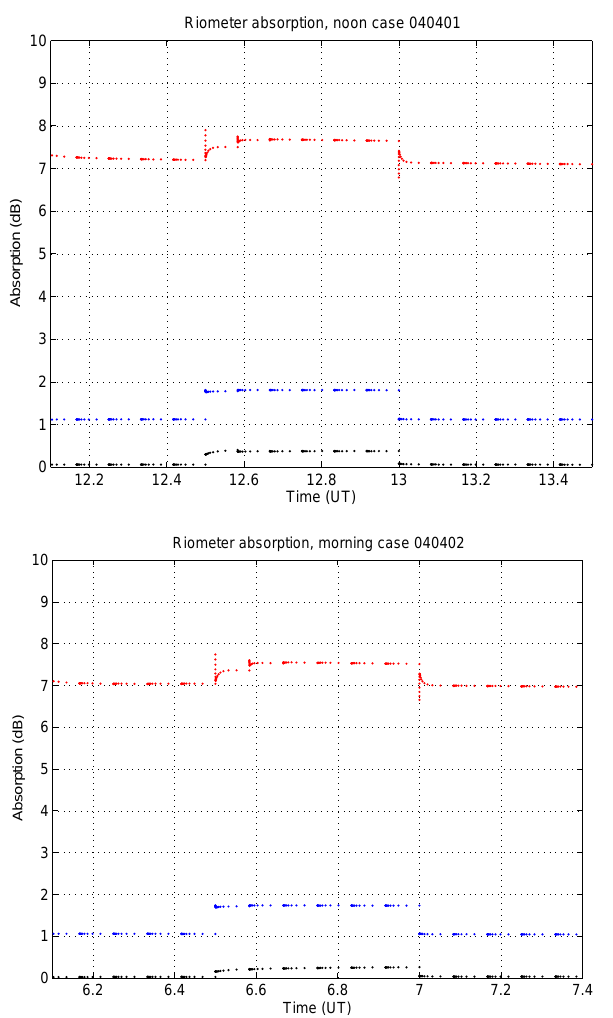
Fig. 6. Time series of modelled cosmic noise absorption at 38.2MHz as observed by a narrow riometer beam tilted by 45 ◦ for the 8-MHz heating runs. Plot 1: The noon-time quiet (black curve), electron (blue curve) and proton (red curve) cases; Plot 2: The morning quiet (black curve), electron (blue curve) and proton (red curve) cases.